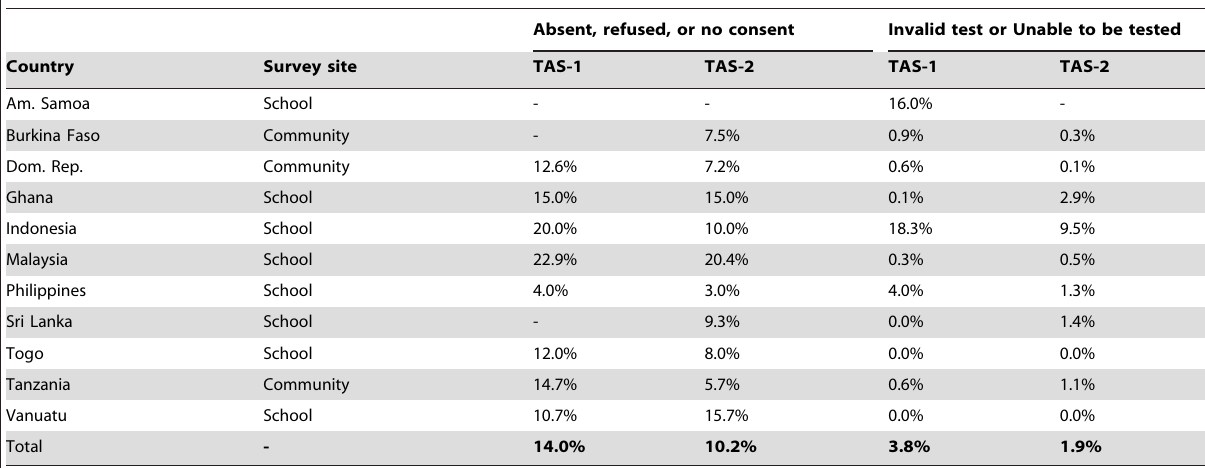
Table 8. Non-participation rates observed in TAS-1 and TAS-2.